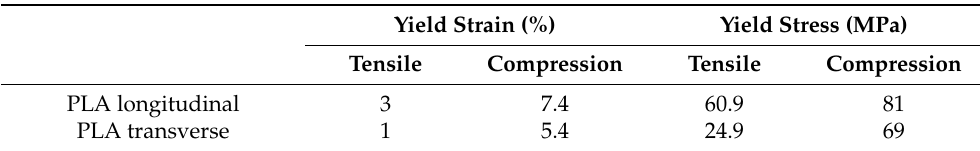
Table 1. Yield stress and strain for 3D-printed PLA material determined by uniaxial tensile and compression tests.